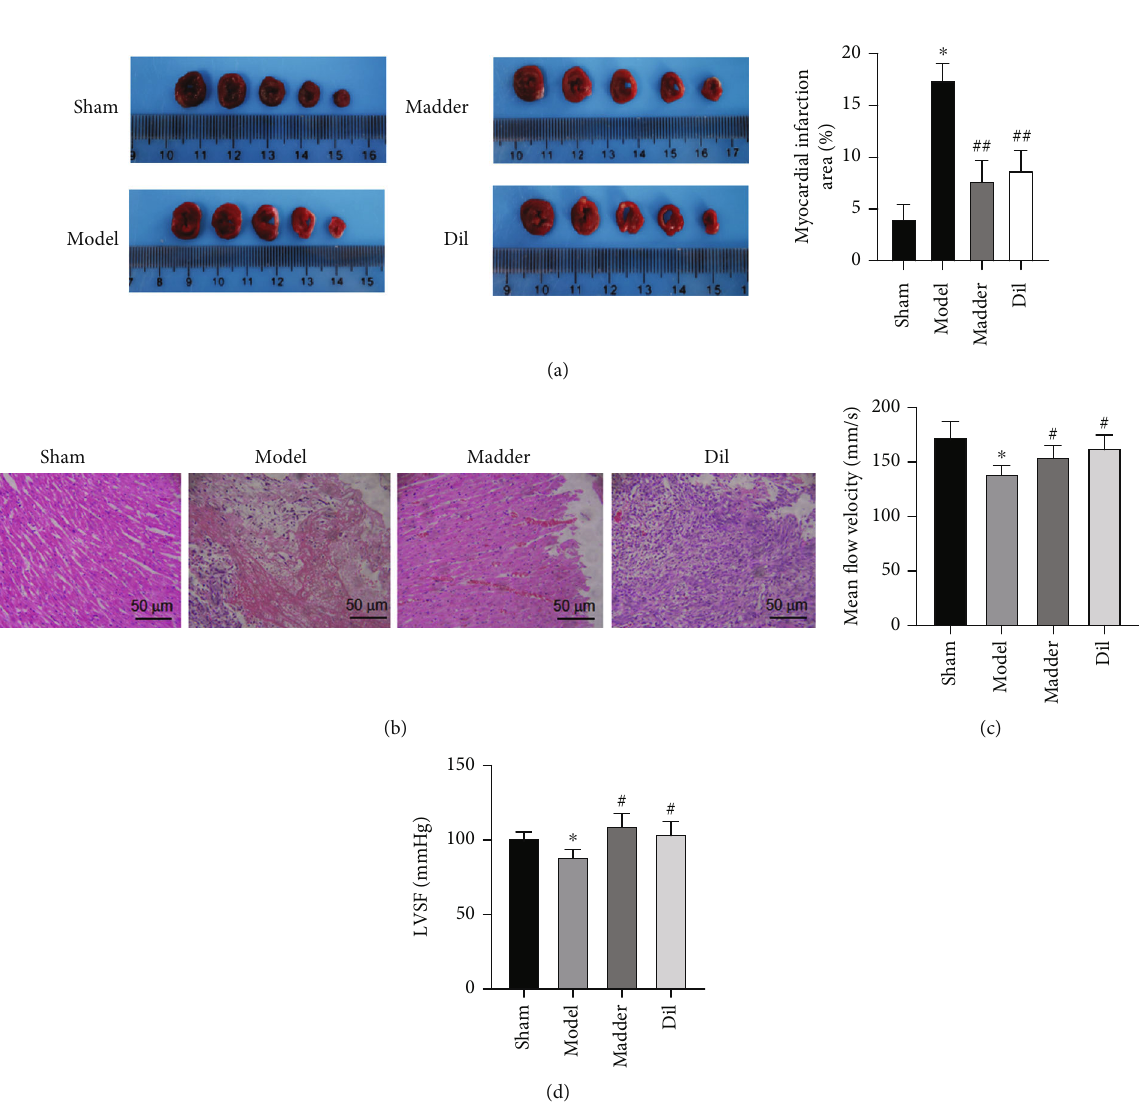
Figure 1: E ff ect of madder treatment on myocardial infarction and myocardial injury in rats: (a) TTC staining was used to determine the size of myocardial infarction in rats; (b) HE staining was used to detect the integrity of the myocardial structure and the degree of the lesion; (c) detection of coronary artery fl ow velocity in rats; (d) detection of systolic myocardial rate in rats. ∗ P < 0 : 05 , compared with the sham group; # P < 0 : 05 , compared with the model